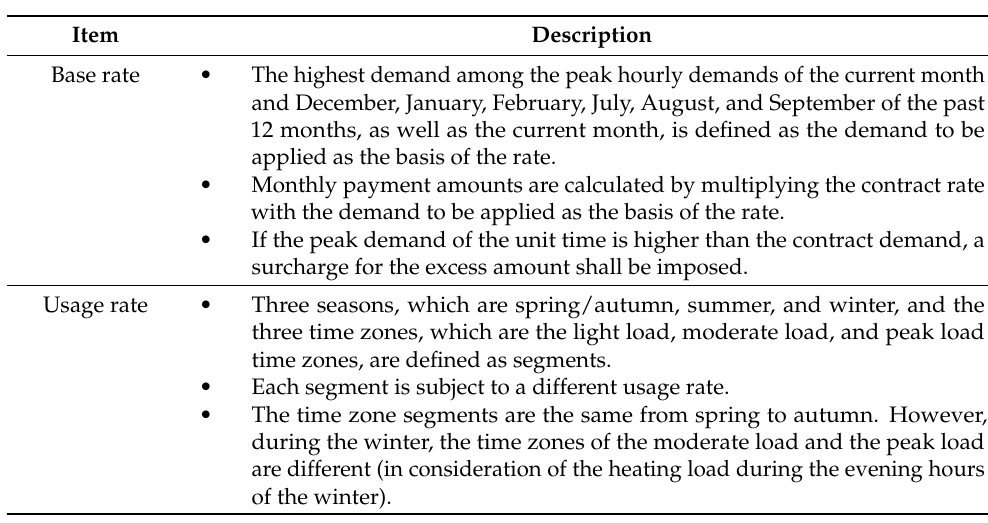
Table 3. The general and industrial power billing structure of the